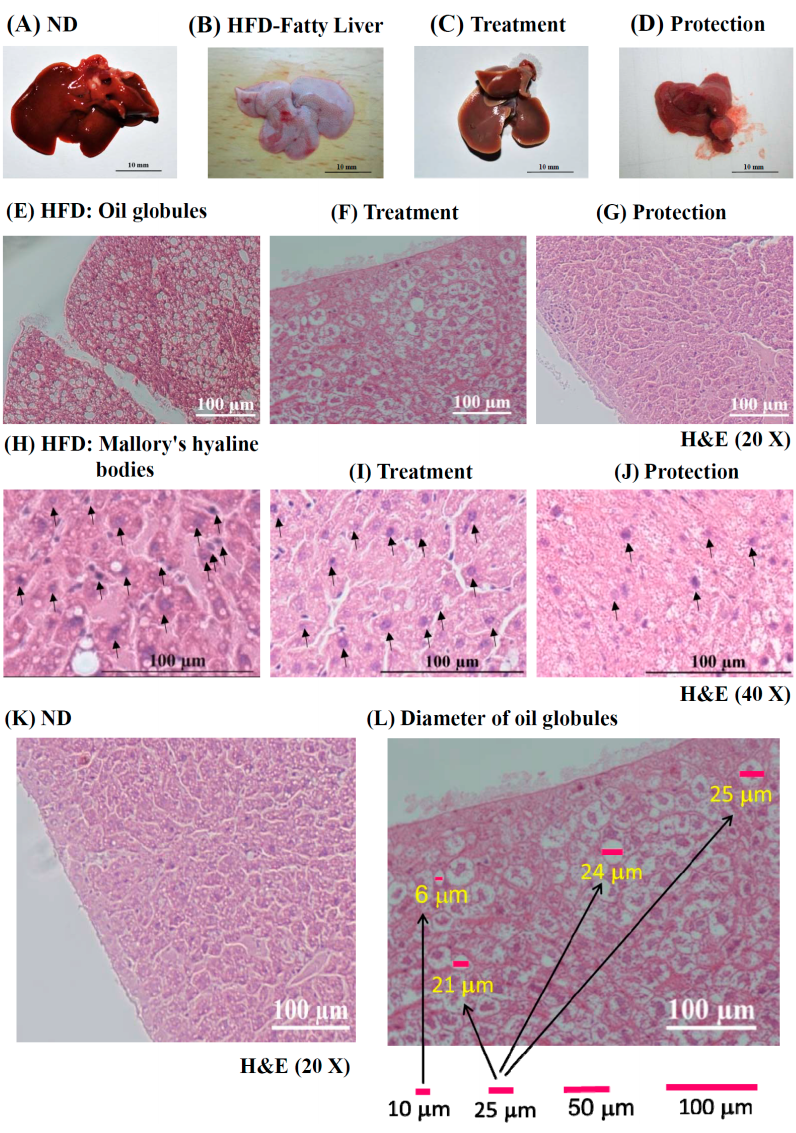
Figure 2. Morphology of livers protected or treated with KMUP-1 in HFD mice shown by H&E staining and the diameter of oil globules measured. ( A ) Normal morphology of livers in mice fed with normal chow diet (ND) for 14 weeks; ( B ) Mice fed with HFD for 14 weeks induced relevant fatty liver; ( C , D ) represent the Treatment and Protection of liver changes by oral gavage of KMUP-1 (2.5 mg/kg/day) for 14 weeks in HFD mice; ( E ) Excessive oil globules in HFD liver at 14 weeks; ( F ) Treatment and ( G ) protection of fatty livers by KMUP-1 for 6 weeks and 14 weeks, respectively; ( H ) Large amount of Mallory’s hyaline bodies (purple dots indicated by black arrow) were observed in the HFD group; ( I ) Obese animal treated with KMUP-1 (2.5 mg/kg/day) for 6 weeks decreased the worst pathologic changes at 14 weeks, i.e., the oil globules and Mallory’s hyaline bodies were attenuated at 14 weeks; and this response was more prominent in the ( J ) protection group; ( K ) shows H&E staining of the liver from normal chow diet (ND) mice as a control; ( L ) A representative example for measuring of hepatic oil globules from Figure 2F. The standardized diameters of 10, 25, 50 and 100 µm are depicted.